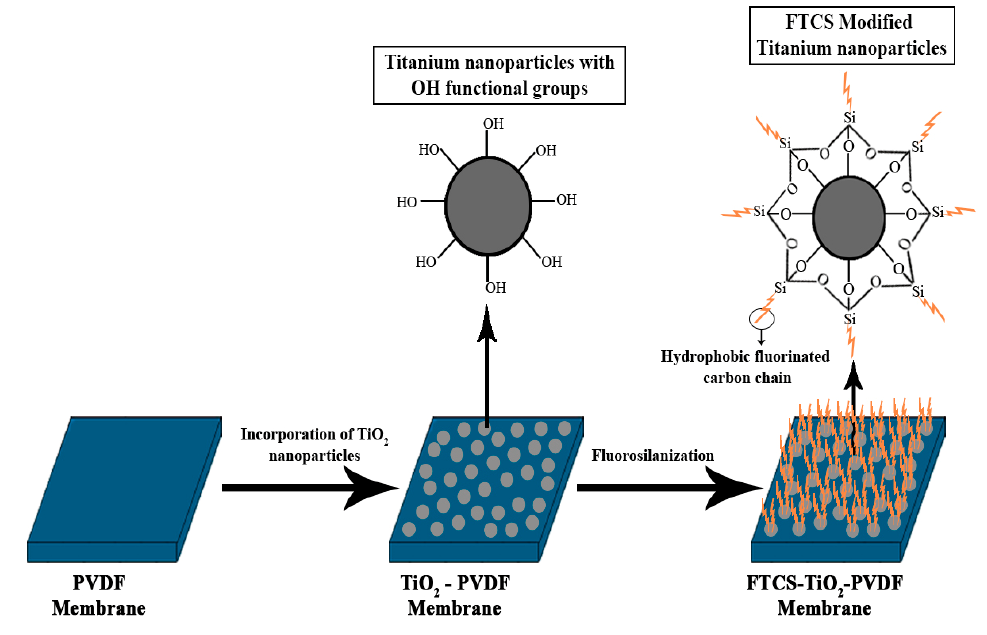
Figure 7. Schematic diagram for the superhydrophobic modification of FTCS-TiO2-PVDF membranes.